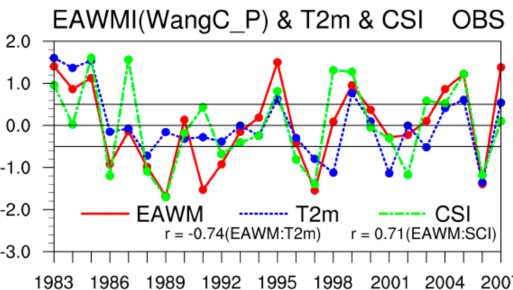
Figure 4. Normalized time series of the DJF EAWM index defined by Wang and Chen (2014) (red solid line), the DJF mean air temperature at 2 m averaged over East Asia (100–145 ◦ E, 20–50 ◦ N) (blue dotted line) and the Southeast Asian cold-surge index defined by Chang et al. [43] (green dotted